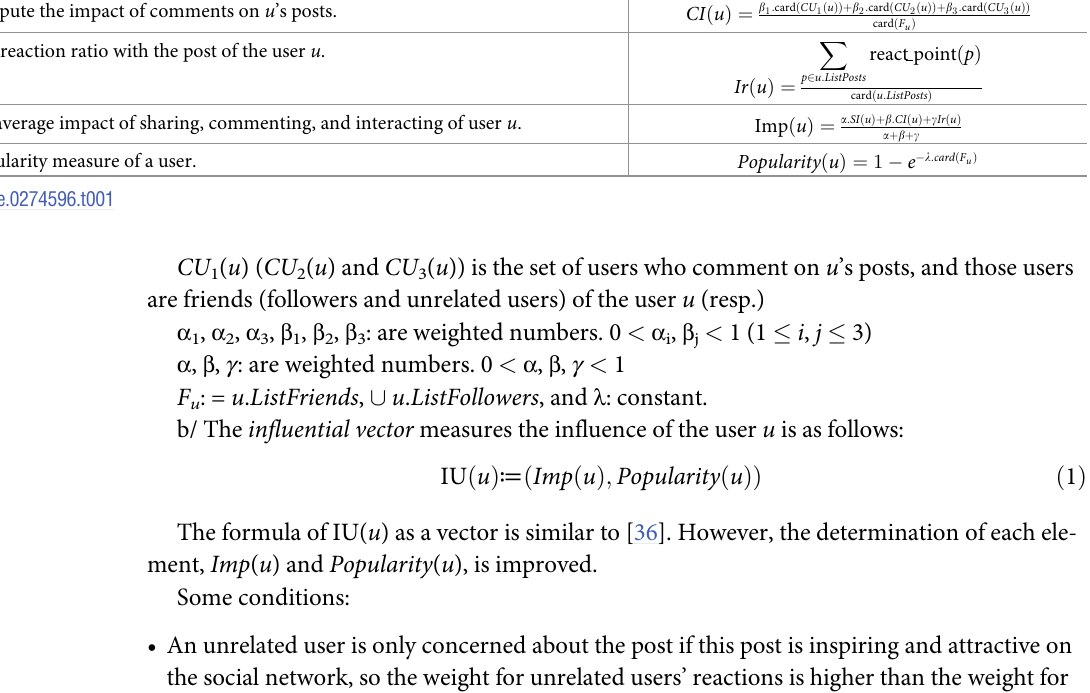
Table 1. Metrics of a user. Measures Meaning Formulas SI ( u ) compute the effect of the user’s post in terms of the shared posts. compute the impact of comments on u ’s posts. The reaction ratio with the post of the user u .